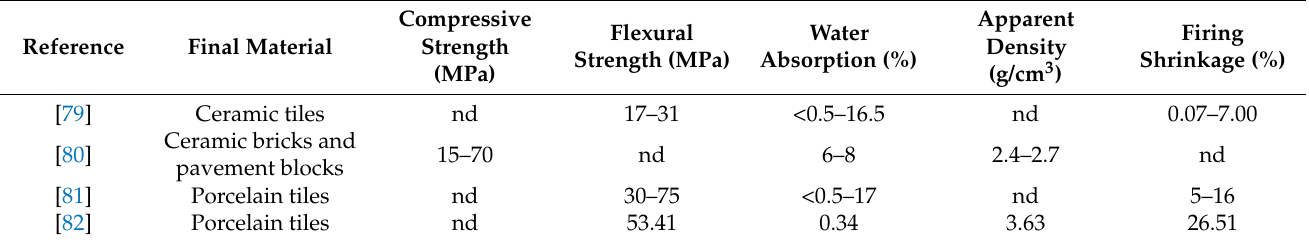
Table 3. Technological properties of mullite-based materials developed from iron mining waste.